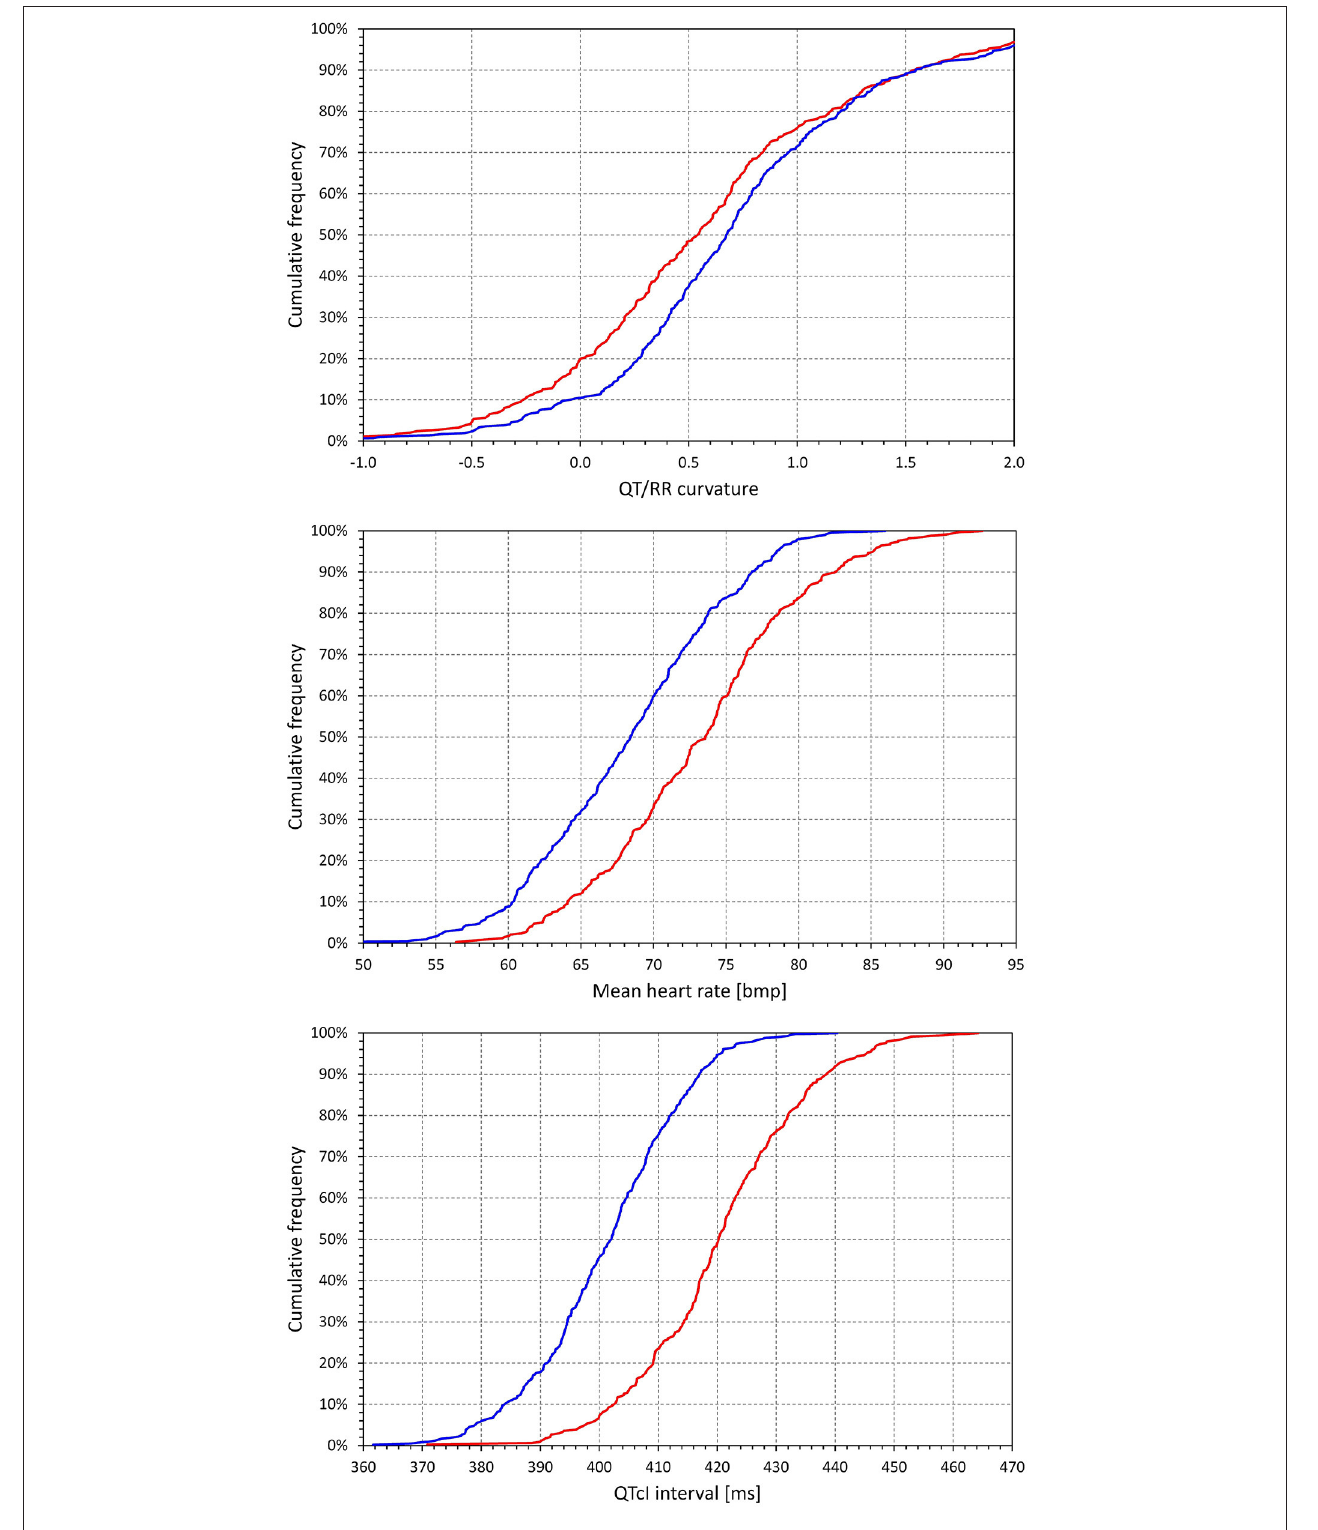
FIGURE 5 | Cumulative distributions of the subject-specific characteristics of the curvature QT/RR H model combined with time-based curvature QT/RR hysteresis model. The distributions of model curvature (parameter γ ), mean heart rate derived from the RR H values, and mean individually corrected QTc intervals are shown in the top, middle, and bottom panels, respectively. The red and blue lines correspond to females and males, respectively.